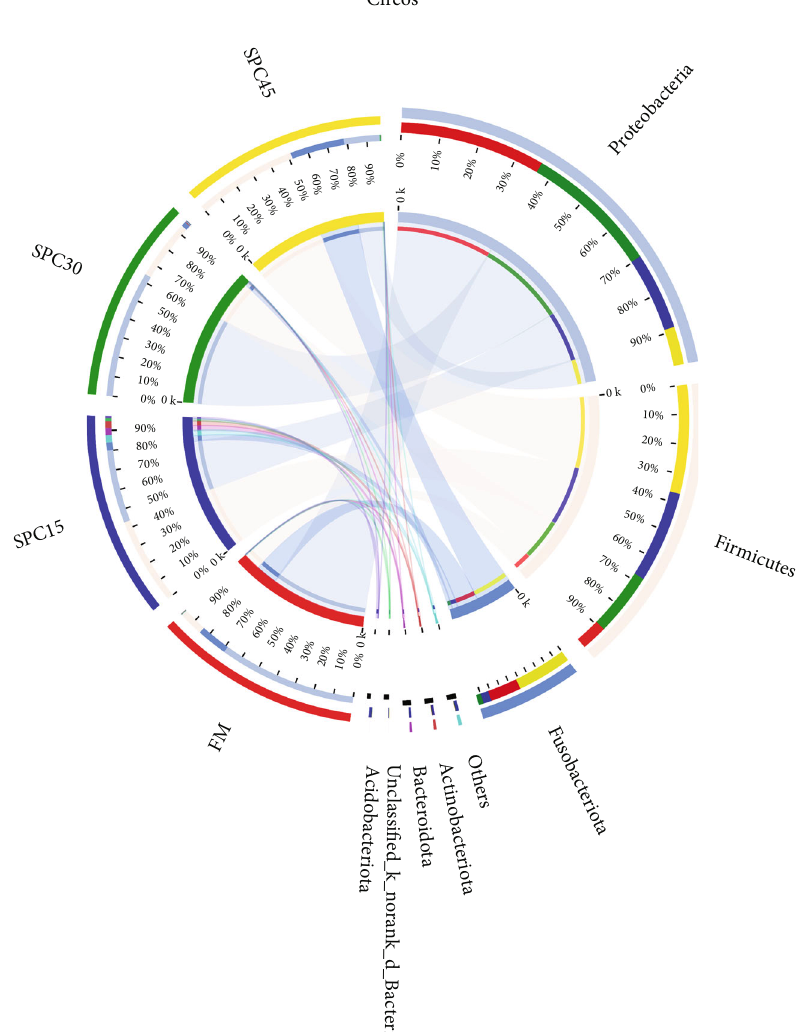
Figure 5: Di ff erences in relative abundance of microbial community in intestine of large yellow croaker fed the experimental diets on phylum